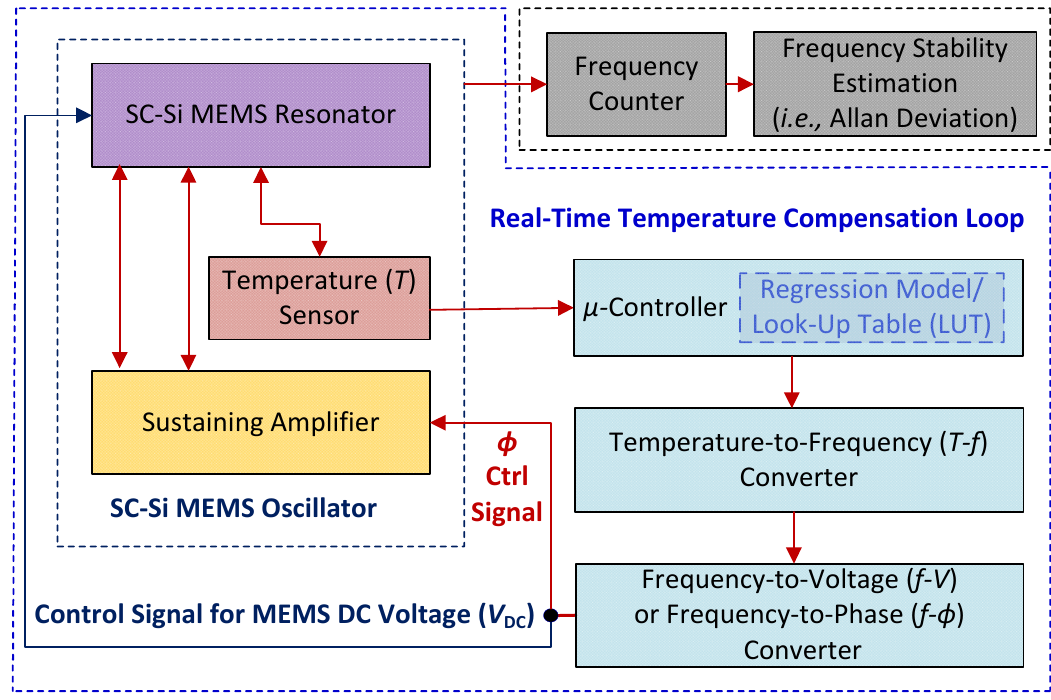
Figure 7. Block diagram of the model calibration procedure, and the proposed real-time temperature compensation